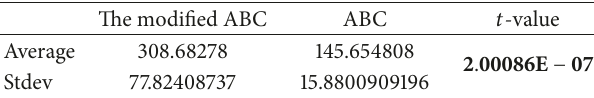
Table 2: The 𝑡 -value for MABC and ABC in 49 degrees of freedom is significant at a QoS level of significance by two-tailed 𝑡